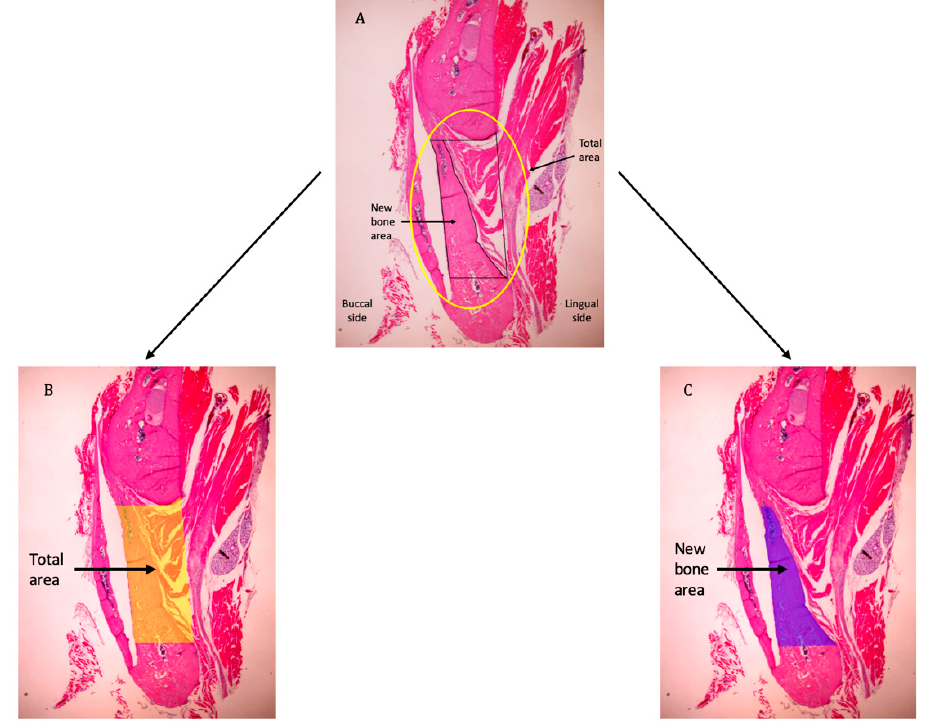
Figure 2. Histomorphometric assessment. The total area consists of the space bordered by the upper and lower bone edges, the lingual side of the reconstructive material, and the line connecting the lingual edges of the bone stumps. ( A – C ) Example images showing selection of the total area and new bone area.